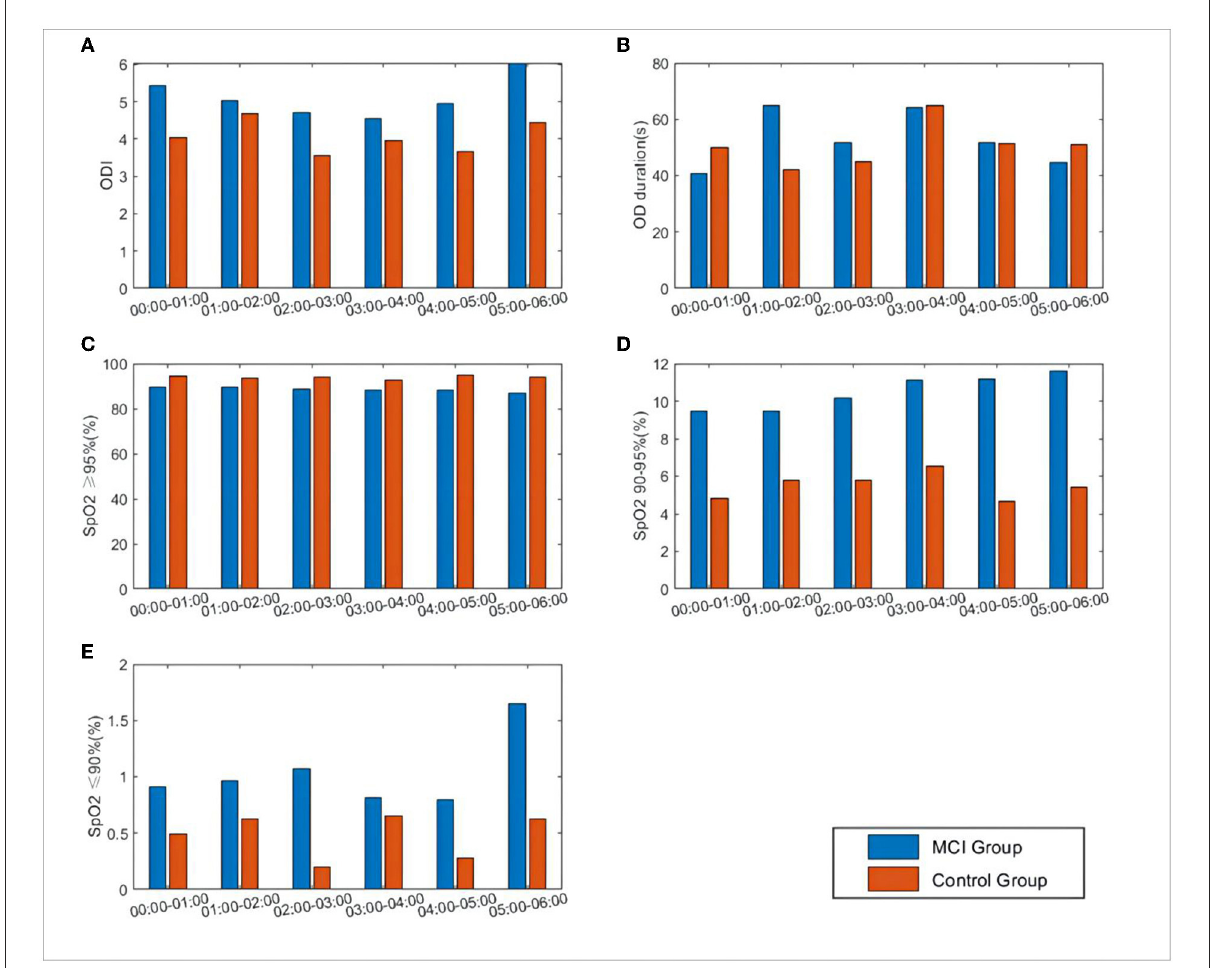
FIGURE4 Differences in SpO 2 and related oxygen desaturation indexes between the two groups during 0:00–6:00. (A) ODI: oxygen desaturation indexes, number of oxygen desaturation in one hour; (B) OD duration: the mean duration of oxygen desaturation in one hour; (C) SpO 2 =